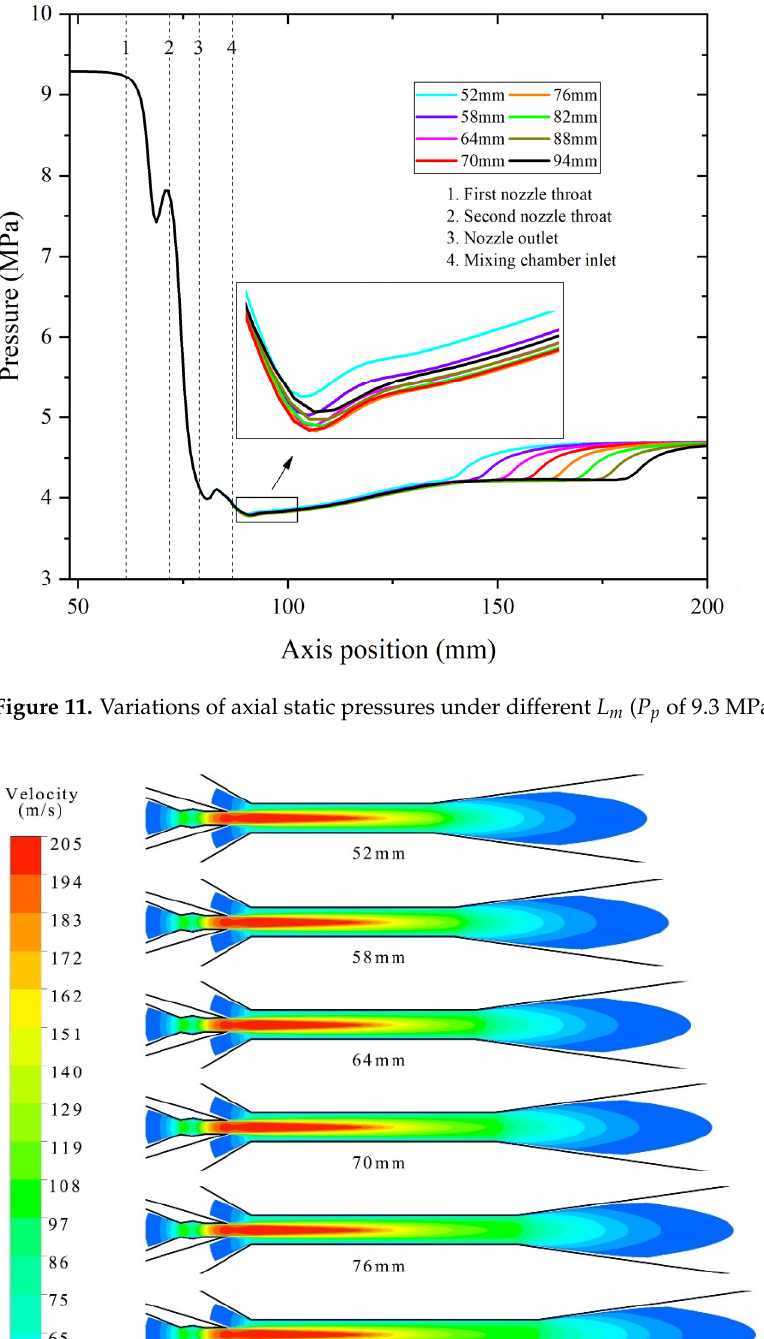
Figure 10. Variations of Er with different L m and P p ( D m of 8 mm, θ pm of 60.4°).